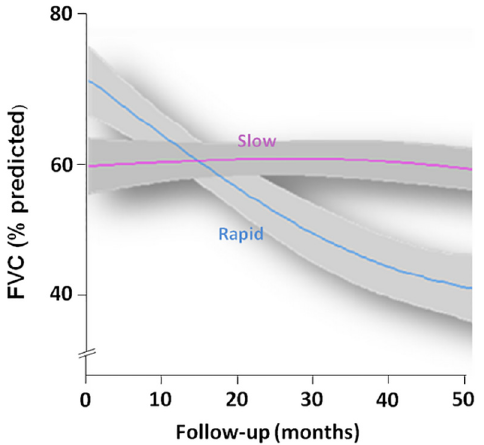
Fig 1. Rate of FVC % predicted decline over time. Time course of the % predicted FVC change in slow and rapid decliners obtained using all the FVC measurements performed during follow-up for each patient. Trends have been estimated using a linear model allowing for non-linearity of time trends, estimated via cubic-splines. The longitudinal trends of the slow and rapid declines are significantly different (p < 0.001). The % predicted FVC at diagnosis (time 0) is significantly higher in rapid than in slow decliners (see Table 1).